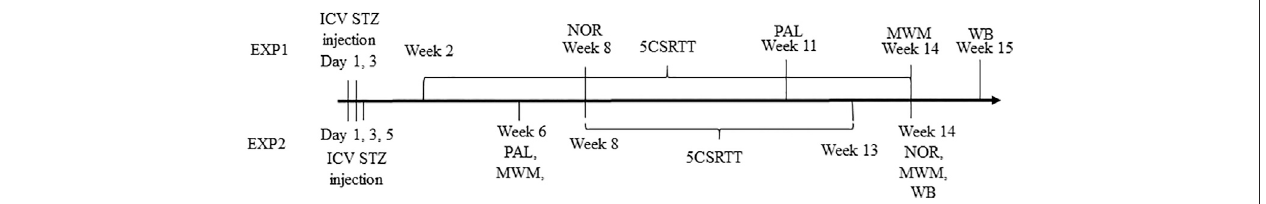
FIGURE 1 | Timeline of the experiments (EXP, experiment; ICV, intracelebroventricular; STZ, streptozotocin; NOR, novel object recognition; 5CSRTT, fi ve choice reaction time task; PAL, passive avoidance learning; MWM, Morris water maze; WB, western